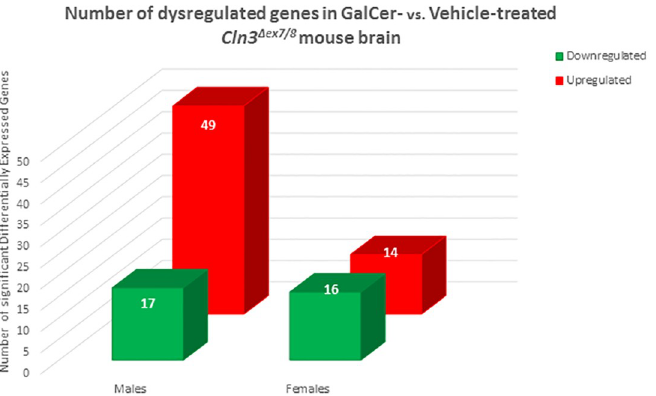
Fig 1. GalCer induces sex-specific alterations in gene expression in Cln3 Δ ex7/8 mouse brain. Bar chart indicating differences in numbers of significant differentially expressed genes affected by GalCer compared to vehicle treatment in Cln3 Δ ex7/8 male and female mice. A cut-off p-value < 0.05 and fold-change � ± 1.3 were assumed to identify genes significantly modulated by GalCer